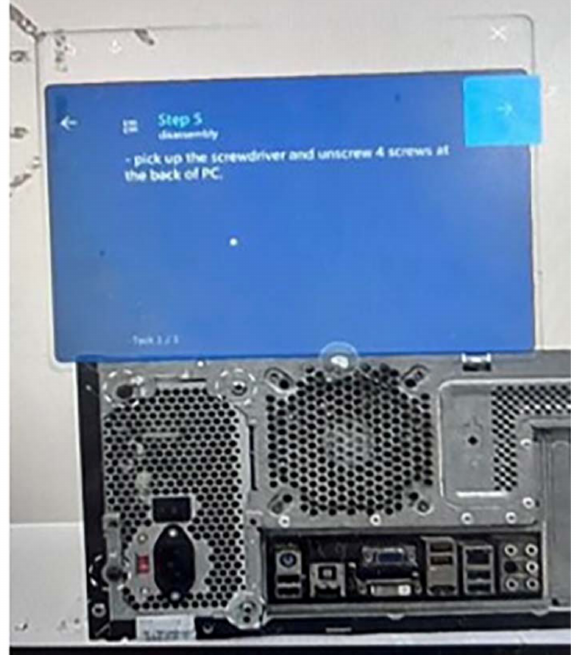
Figure 7. Virtual image in the HoloLens 2 showing both the text explanation to unscrew the power supply unit and the highlighted (dotted circles) screws to be unscrewed and removed (step 5 of disassembly task).